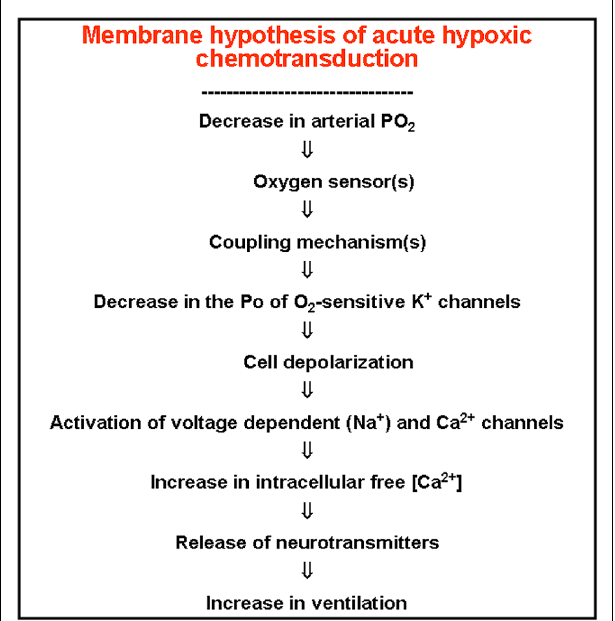
FIGURE 7 |The membrane model of acute hypoxic transduction proposes the cascade of events depicted in the figure. On lowering PO 2 , an O 2 − sensor, hypothetically located in the plasma membrane, would experiment a conformational (and reversible) change, which transmitted to oxygen-regulated K + channels would cause modifications in their kinetic properties, resulting in a decrease in their opening probability. The ensuing depolarization activates voltage dependent Ca 2 + channels and entry of Ca 2 + in the cells triggering the exocytotic release of neurotransmitters, increase in CSN action potentials and in ventilation (redrawn from González etal.,